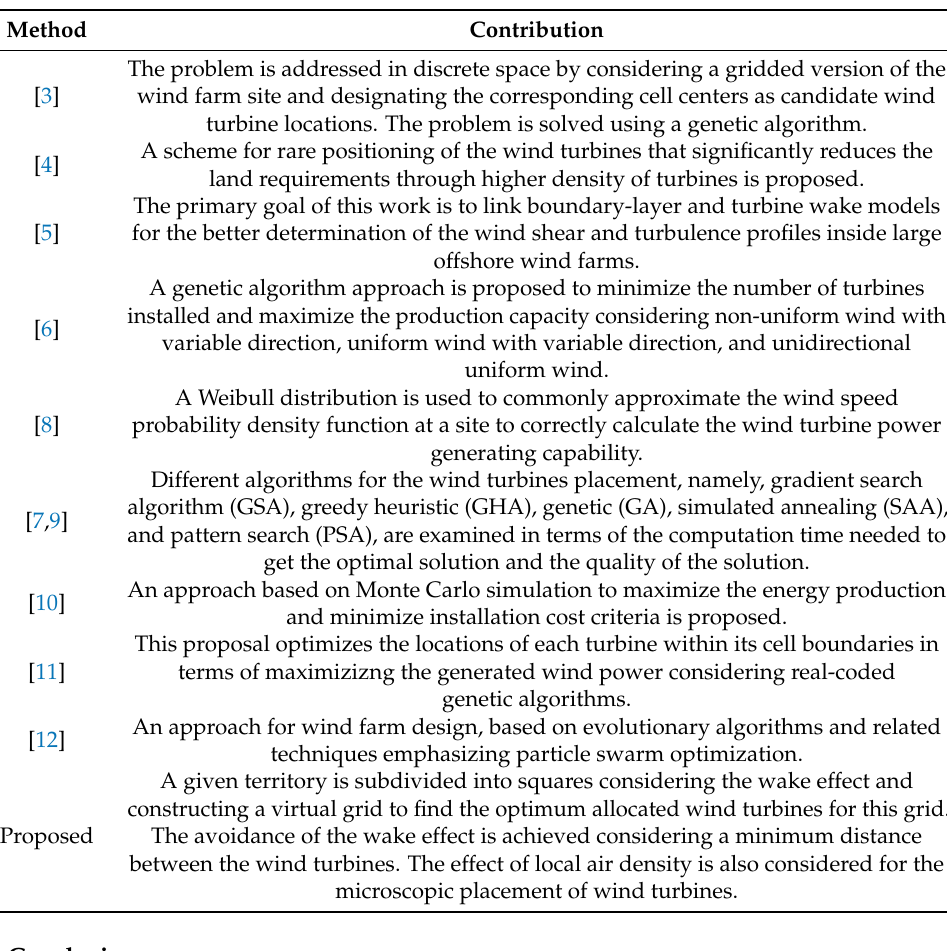
Table 4. Qualitative comparison of the proposed BIP method with other works in the literature.